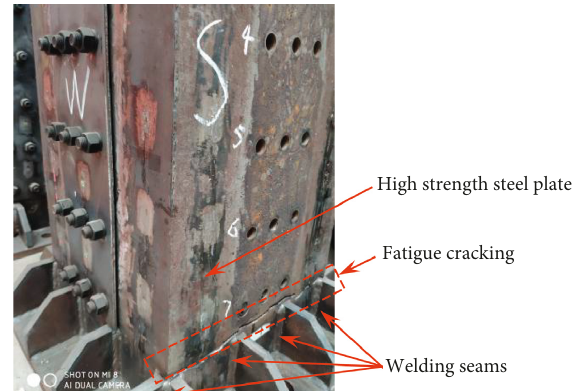
Figure 1: Fatigue cracking of the high-strength steel plate with welding seams under repeated